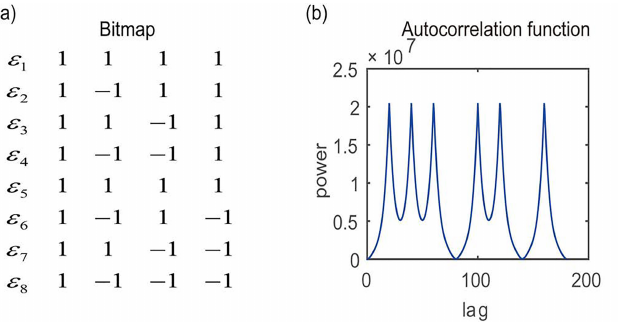
Figure 1. The 4-bit strong alternating code bitmap and autocorrelation